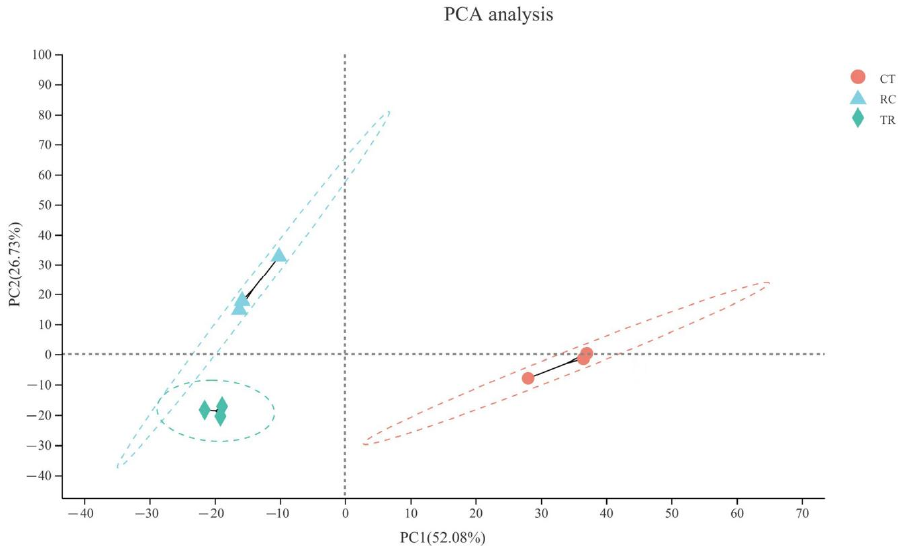
Figure 4. The principal component analysis (PCA) analysis between three samples. After dimensionality reduction analysis, the samples have relative coordinate points on the principal components. The distance of each sample point represents the sample distance, and the closer the distance is, the higher the similarity between samples. The horizontal axis represents the contribution degree of principal component 1 (PC1) in the two-dimensional graph to the distinguished samples, and the vertical axis represents the contribution degree of principal component 2 (PC2) in the two-dimensional graph to the distinguished samples. CT: Normal-temperature treatment. TR: Low-temperature treatment. RC: Recovery to normal-temperature treatment.